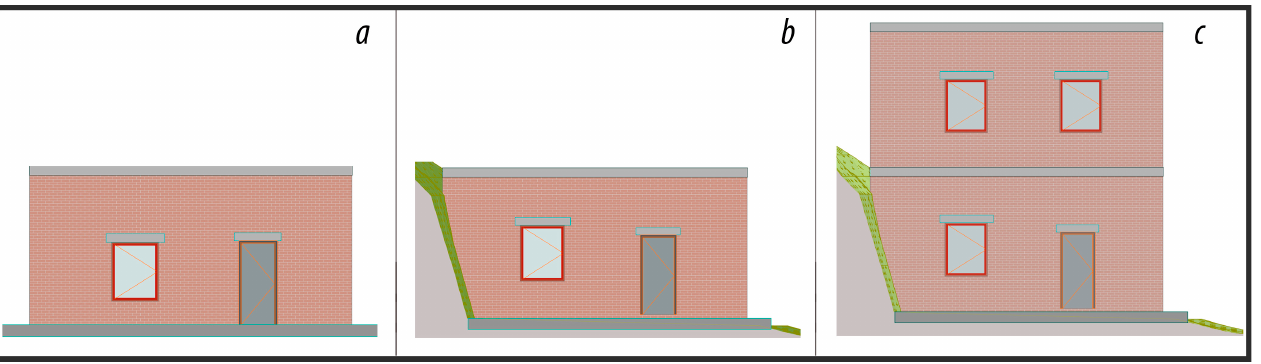
Figure 13. Differences between the floors according to the facade: ( a ) None, ( b ) Available, ( c ) Available.